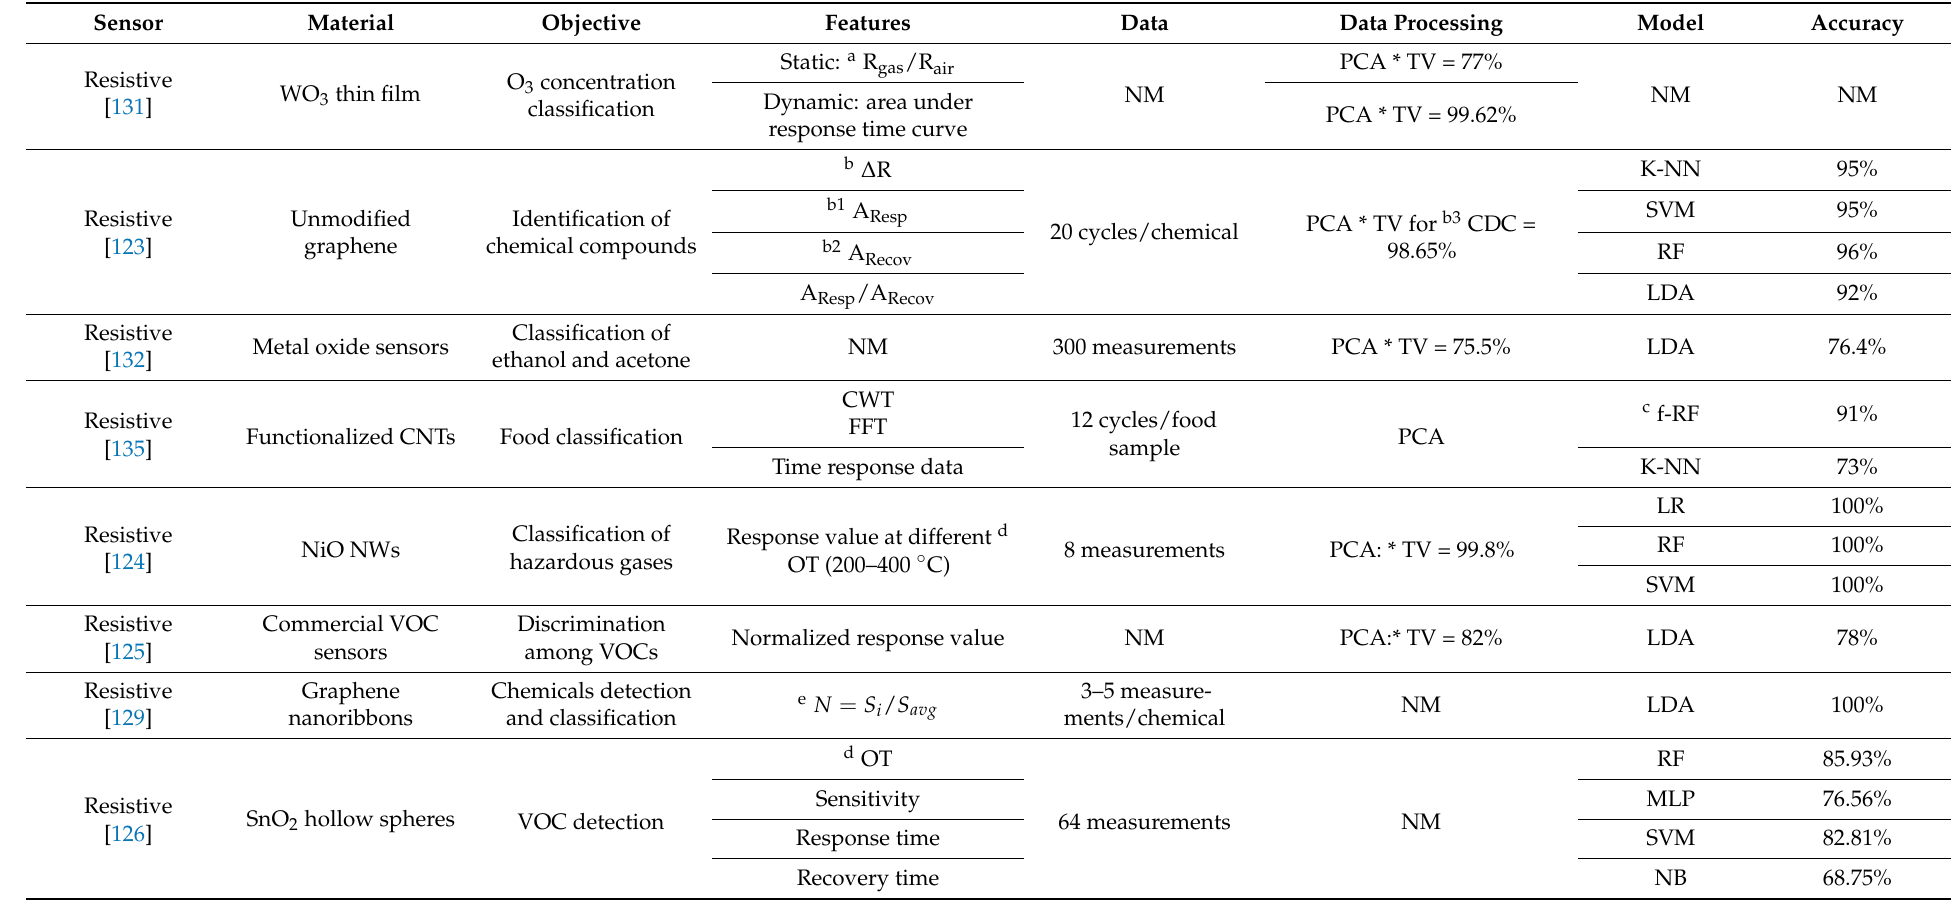
Table 1. A comparison of some of the reported extracted features and output accuracies for chemiresistive